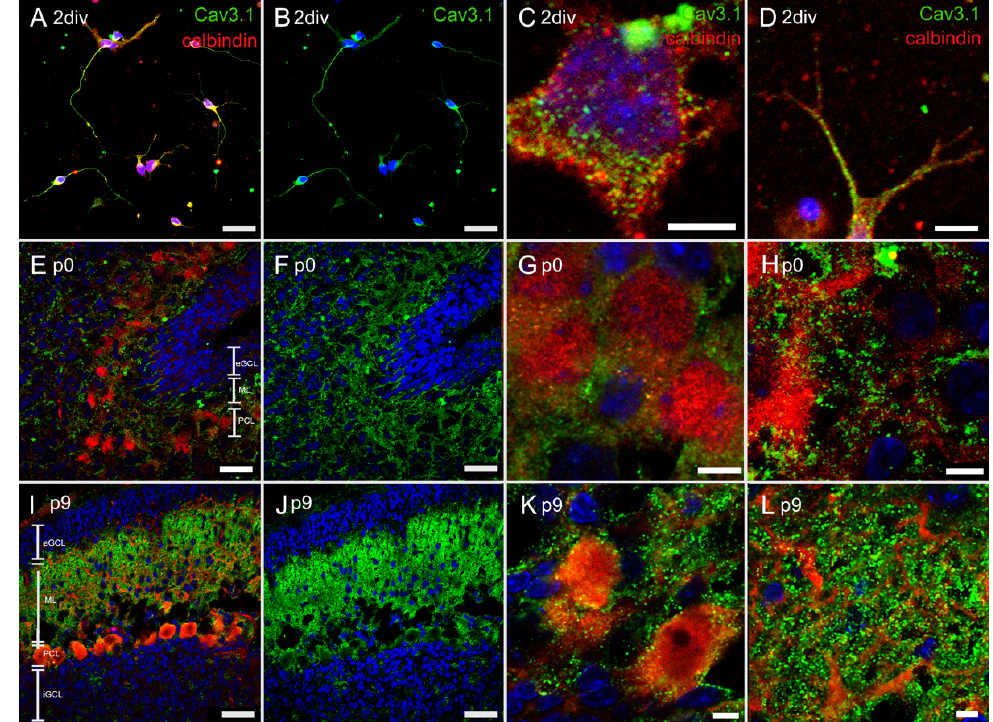
Figure 4. In vivo and in vitro expression of Cav3.1: Immunostaining of Cav3.1, in dissociated PCs at 2div ( A – D ) and cryosections of rat cerebella at p0 ( E – H ) and p9 ( I – L ). Cav3.1 (green), calbindin (red) and nuclear staining with Hoechst (blue). The cryosections showed the physiological layers of the cerebellum, namely, the external granular cell layer (eGCL), the molecular layer (ML), the PC layer (PCL), and the internal granular cell layer (iGCL). The in vitro PCs grown in serum-free medium developed dendrites or axons, with a clear Cav3.1 signal. Scale bar: 20 µm ( A , B , E , F , I , J ) and 5 µm ( C , D , G , H , K , L ).